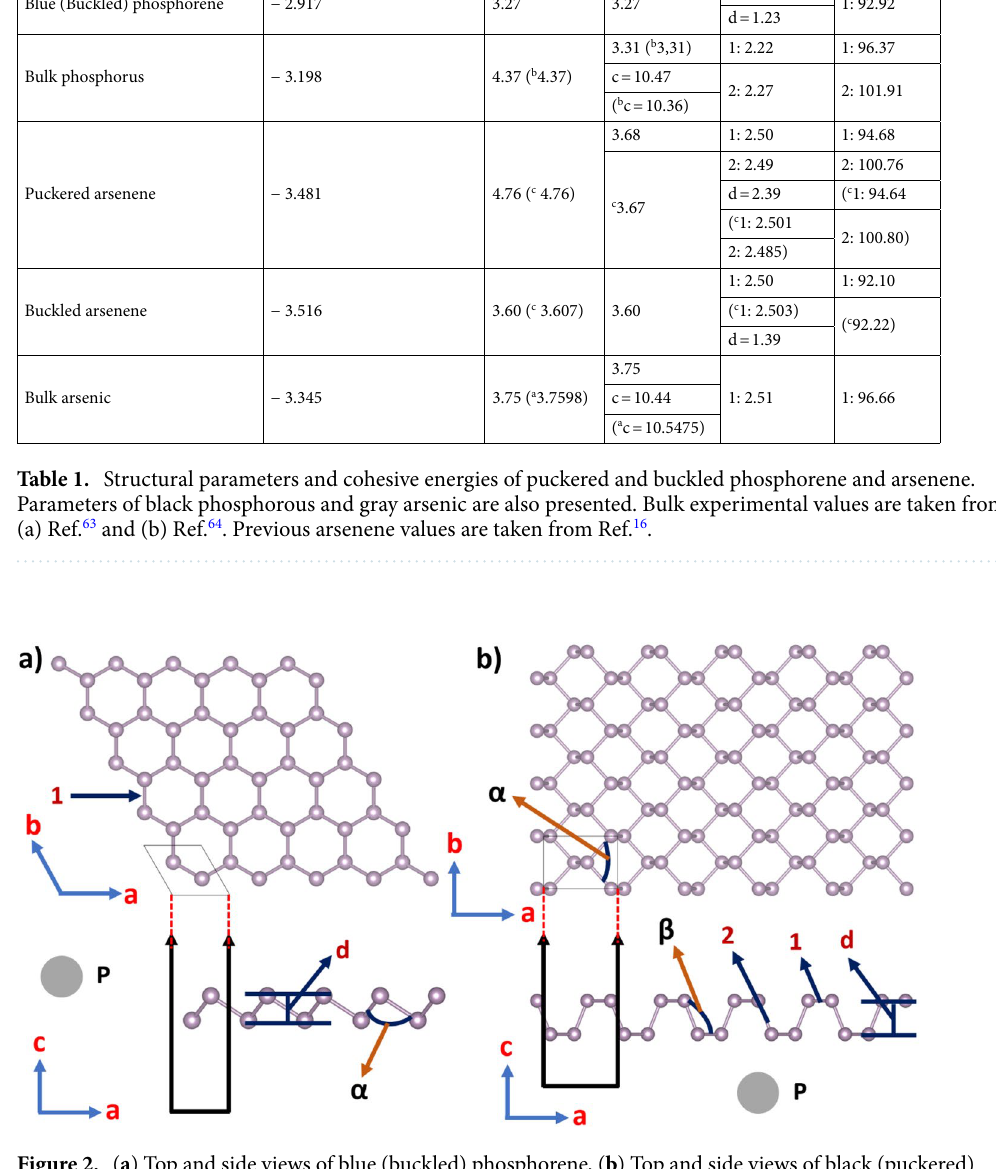
Figure 2. ( a ) Top and side views of blue (buckled) phosphorene, ( b ) Top and side views of black (puckered) phosphorene. 1 and 2 correspond to the bond lengths, α and β correspond to bond angles of Table 1. Figure generated by using the open-source GIMP (GNU Image Manipulation Program) version 2.8.22 (URL: https:// www. gimp.